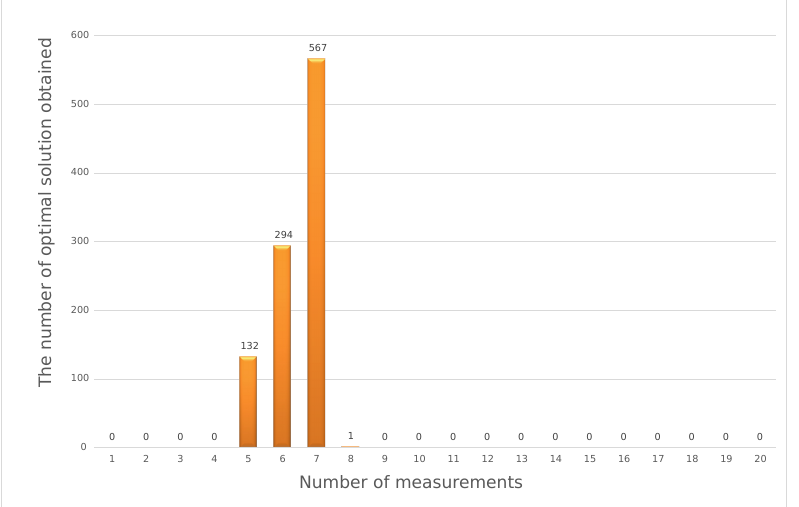
Figure 7. Optimal solutions with the distance function method for a simulated series of 1000 sets of input data.